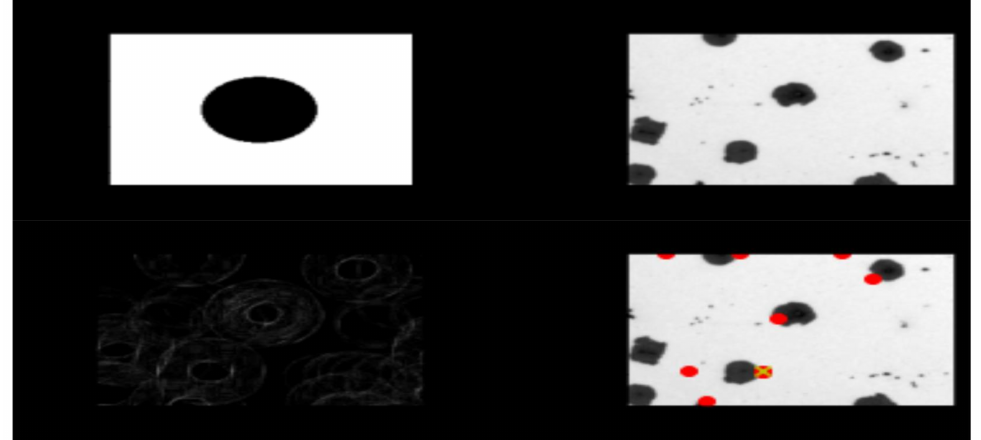
Figure 4. Detecting the shape shown in the reference image in the query image. In the lower right corner, the detected shapes are marked in red. The yellow cross shows the most relevant point. The reference image in this case is a black circle.